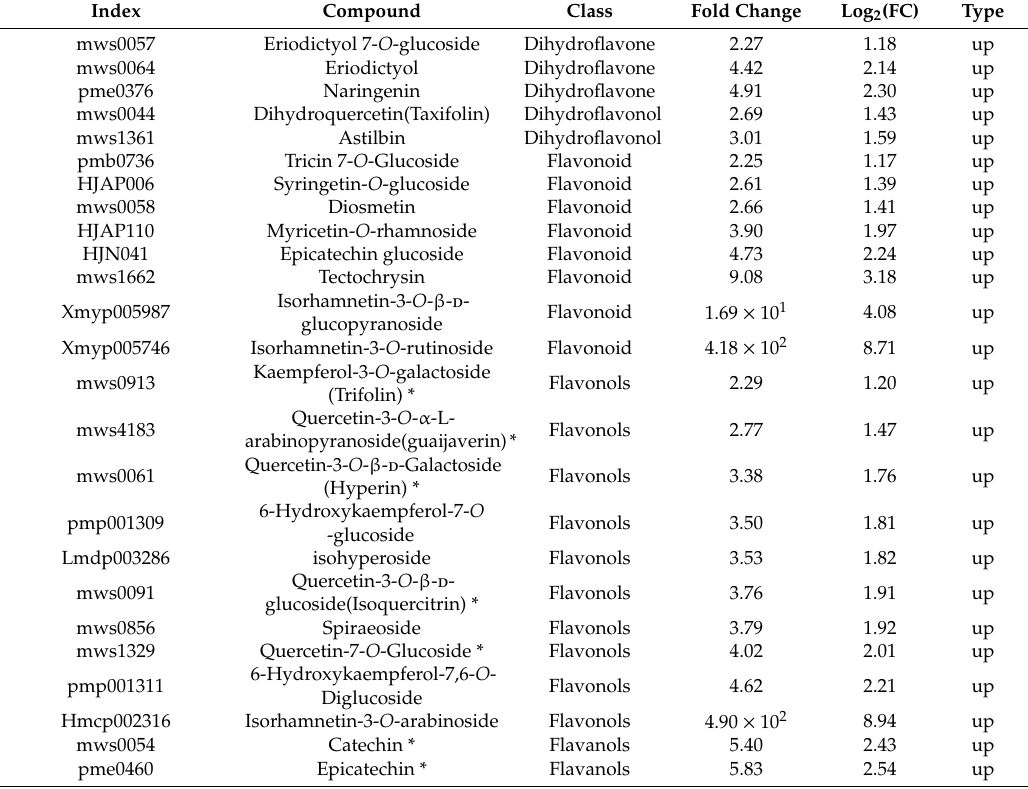
Table 3. DAMs involved in flavonoid